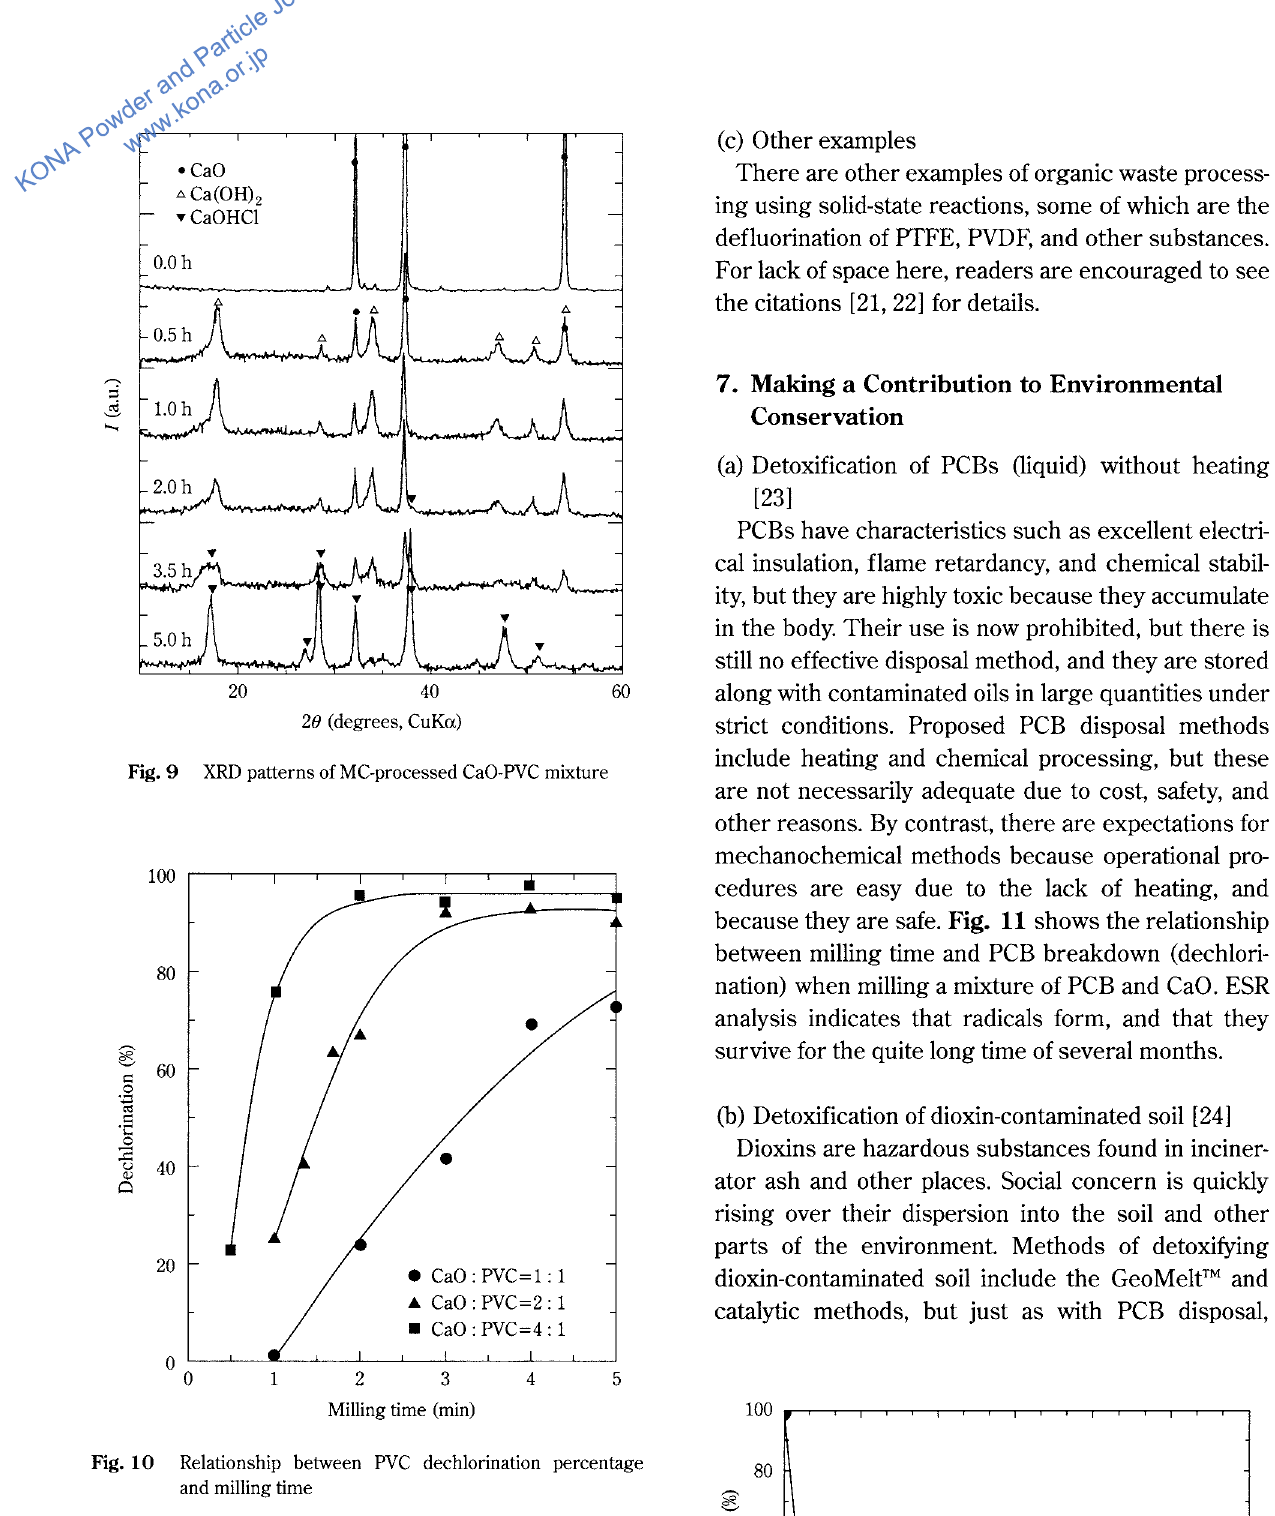
Relationship between PVC dechlorination percentage and milling time